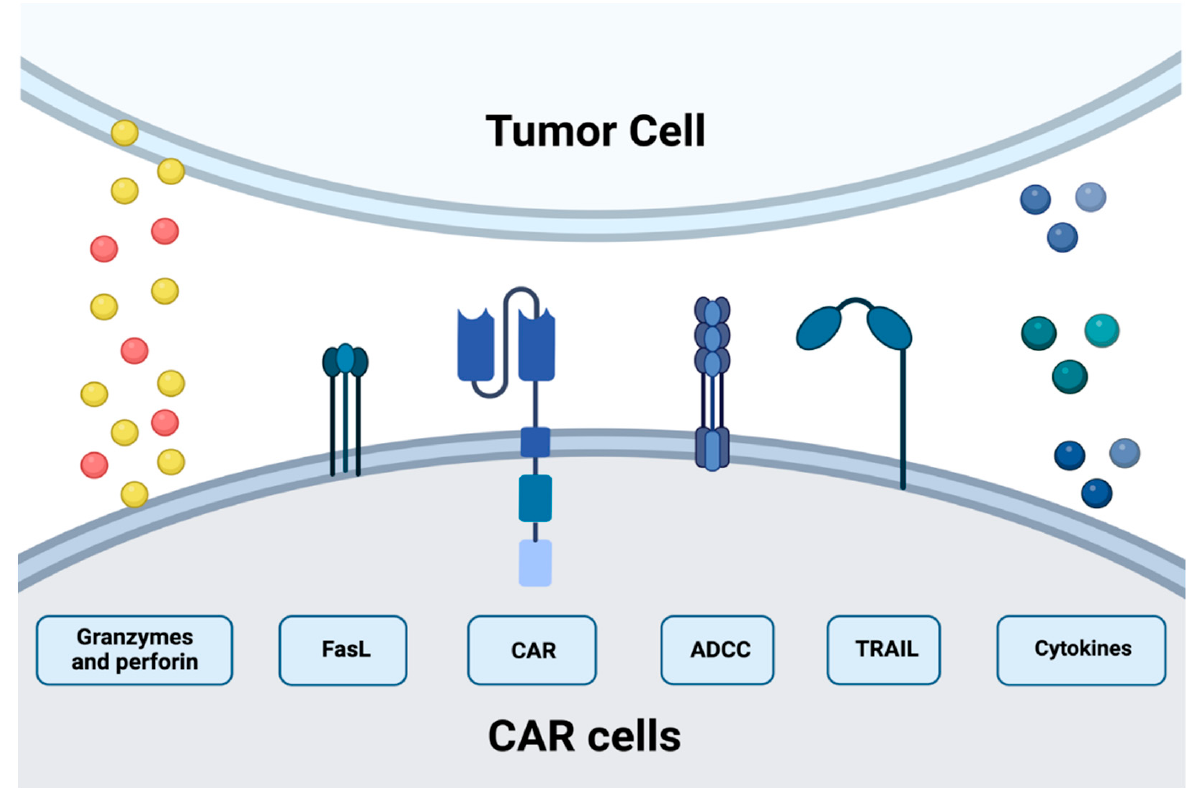
Figure 3. The cytotoxic mechanism of CARs cells.